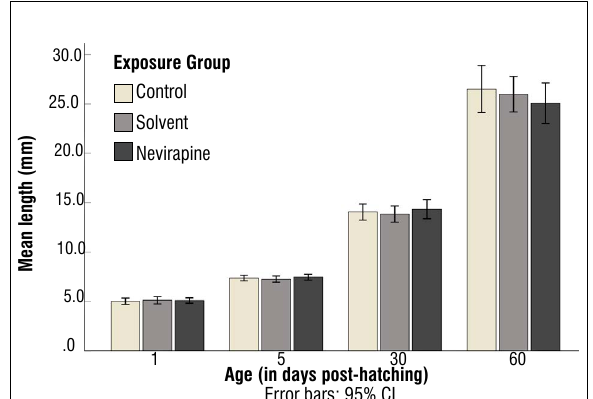
Scatterplot showing the strong positive correlations (upward position from left to right) between mean length and mass measurements of fish in all three exposure groups from Day 1 to Day 60.